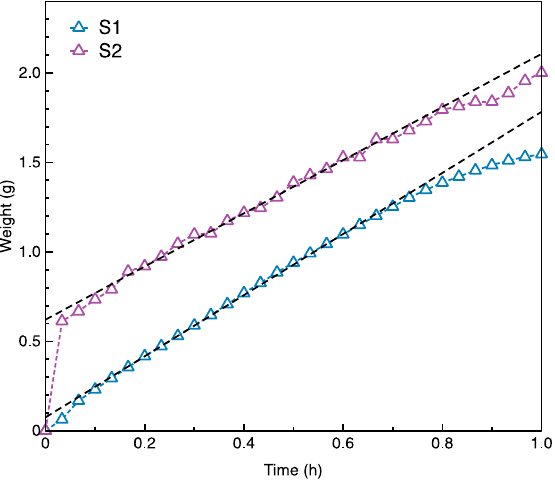
Table 6. Results of air permeability.